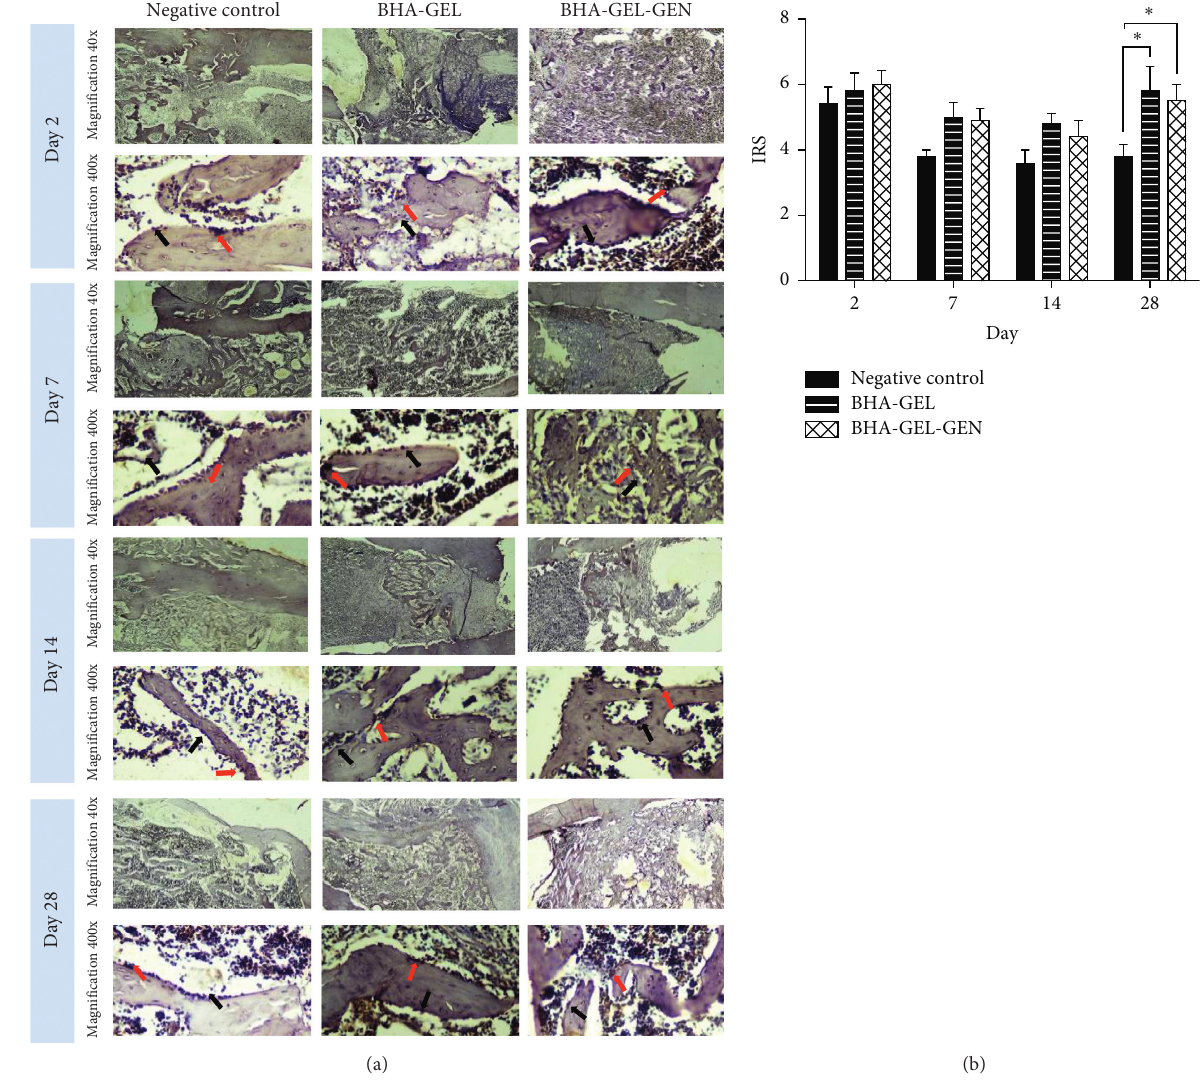
Figure 4: (a) Tangential longitudinal section of rat’s femur stained with anti-ALP. Osteoblasts expressing ALP (red arrow), osteoblasts that did not express ALP (black arrow). (b) Immunoreactive score (IRS) of ALP in each group. Each bar represents the mean IRS ± SEM of the two rats observed in at least two different visual fields. ∗ p < 0 . 05 with Kruskal